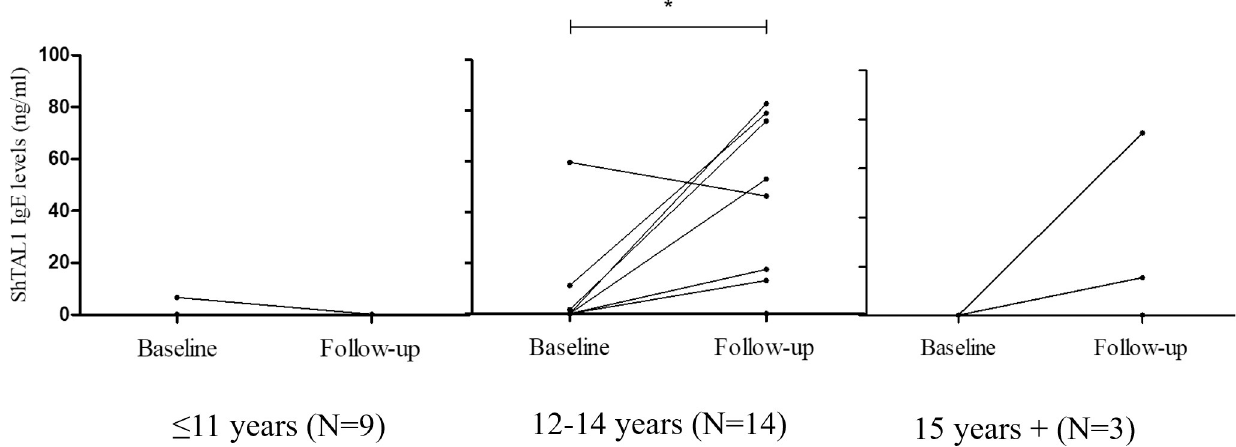
Fig 6. Before-after line graphs of participant ShTAL-IgE titres stratified by age groups. Baseline and post-treatment comparisons within each age groups was conducted using the Wilcoxon paired sign-rank test. � denotes p-values less than 0.05.